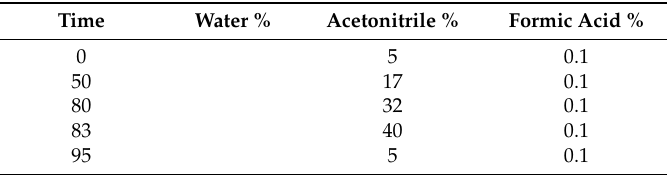
Table 1. Chromatographic gradient used for LC-MS